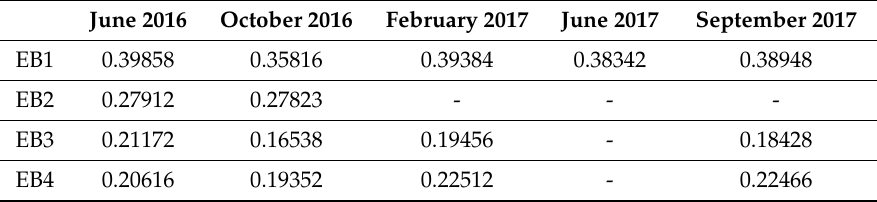
Table 2. Soil properties on trails in Serra do Mar State Park. Coarse sand (2.0–0.2 mm), fine sand (0.2–